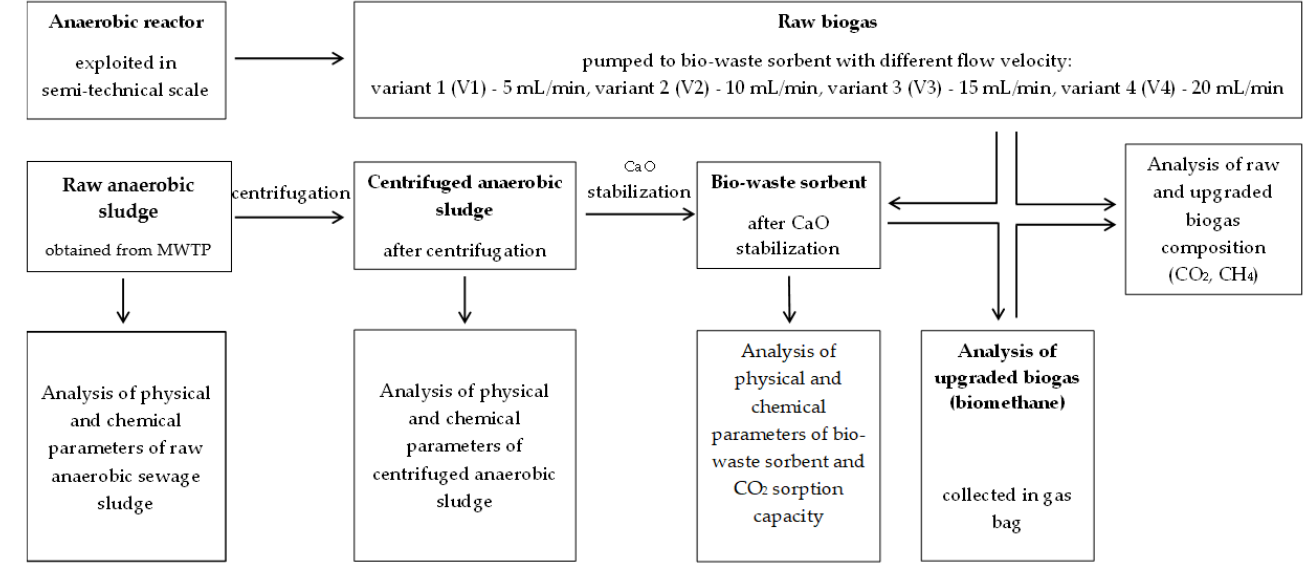
Figure 1. The study organization.